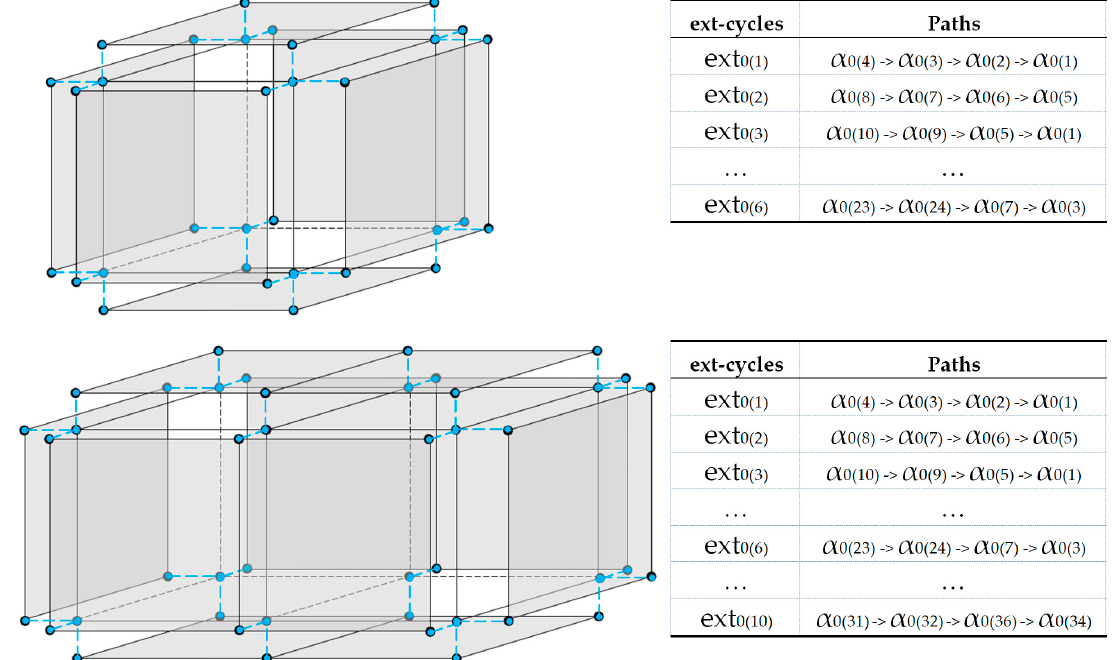
Figure 5. External cycles for a single 3D object (above) and a single 3D connected component object (below).